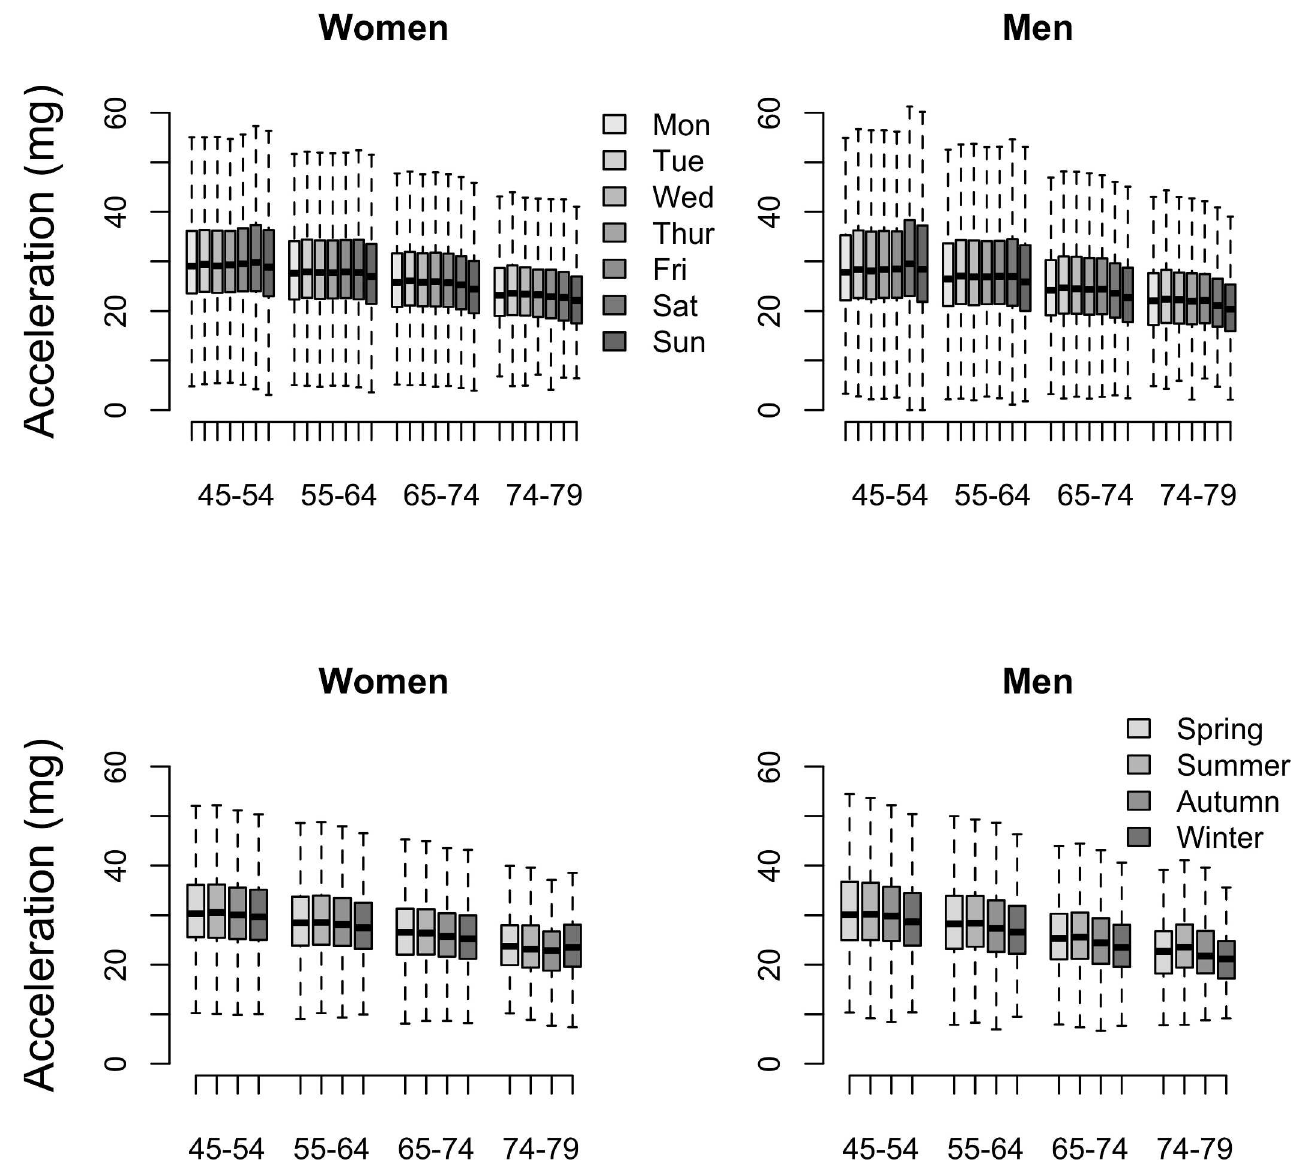
Fig 6. Accelerationvector magnitude by day of the week (top), season (bottom), age, and sex: the UK Biobank study 2013–2015 (n =